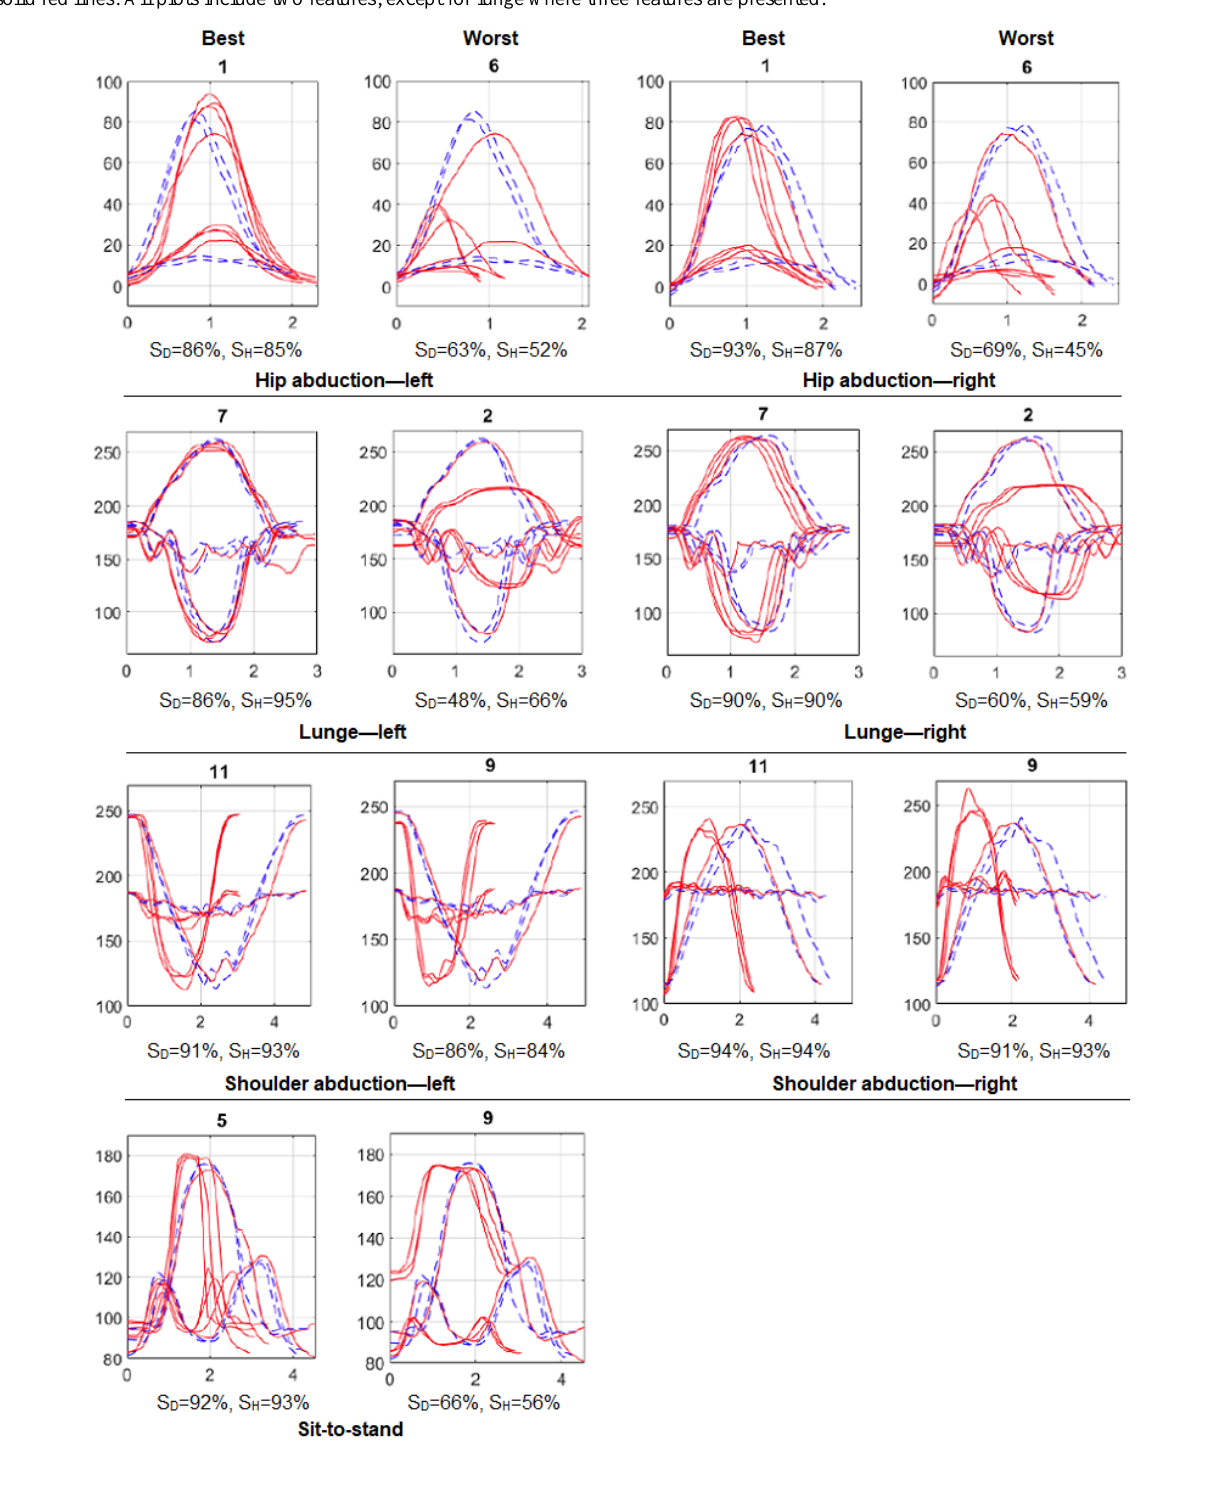
Figure 7. Time-domain plots of the best and worst trajectories (excluding participants 17 and 18). X-axis indicates the time in seconds and Y-axis indicates the joint angle in degree. The three repetitions of the reference trajectories are given in dashed blue lines and the chosen participant’s trajectories in solid red lines. All plots include two features, except for lunge where three features are